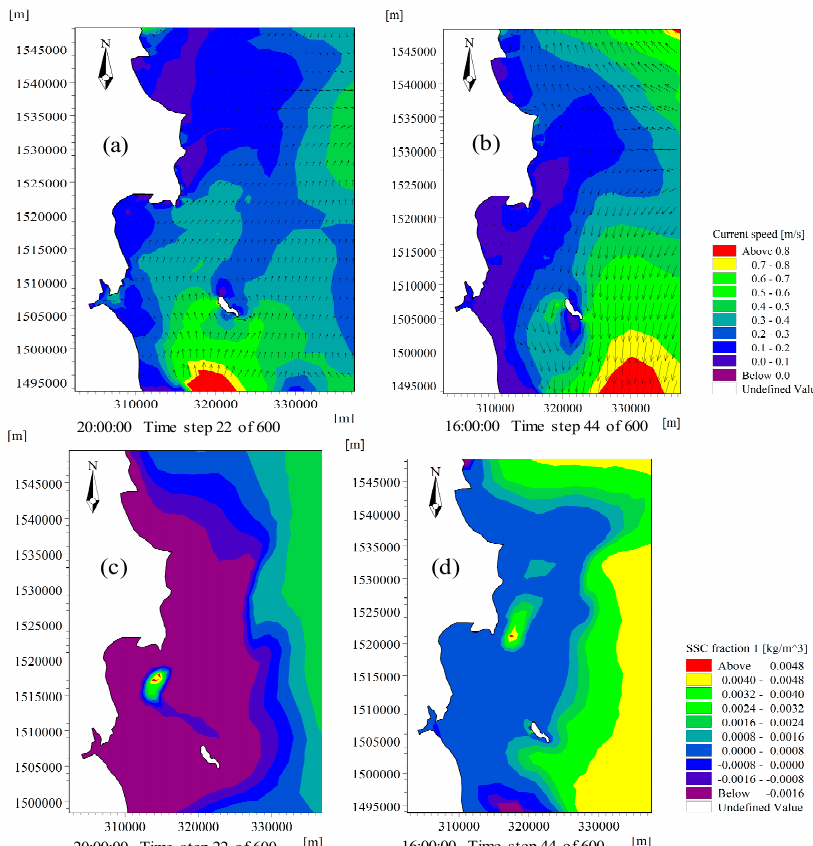
Figure 10. The simulation results of S3. Streamflow field during ( a ) low tide; ( b ) high tide. Figure10. ThesimulationresultsofS3. Streamflowfieldduring( a )lowtide; ( b )hightide. Distributionof Distribution of suspended sediment concentration (SSC) during ( c ) low tide; ( d ) high tide. suspended sediment concentration (SSC) during ( c ) low tide; ( d ) high